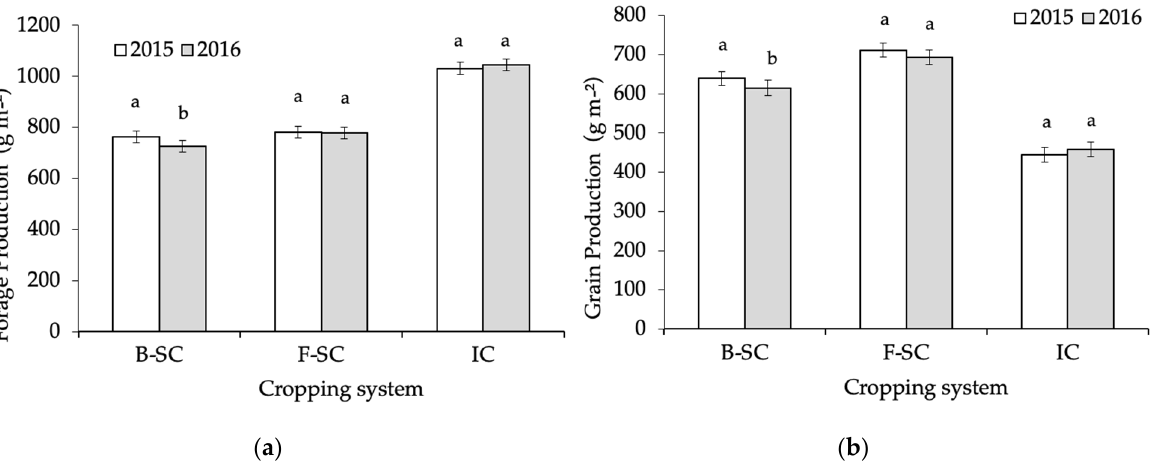
( b ) Figure 1. Air minimum (white dots) and maximum (black dots) temperatures and rainfall (bars) in the two cropping seasons: ( a ) 2014–2015; ( b ) 2015–2016. 3.2. Year Effect on Forage and Grain Production Year main effect and its interactions were not significant for almost all the measured parameters (Supplementary Table S1). Anyway, forage and grain production of the studied cropping systems varied between years, and ANOVA revealed a significant year (Y) x cropping system (CS) interaction (Figure 2). Barley grown as sole crop produced less forage in 2016, while the values of field bean sole crop and those of the intercrop did not differ between years (Figure 2a). In any case, intercropping provided a remarkable increase in the supplied forage biomass compared to the sole crops (by 34% and 39%, respectively, in the two experimental years).